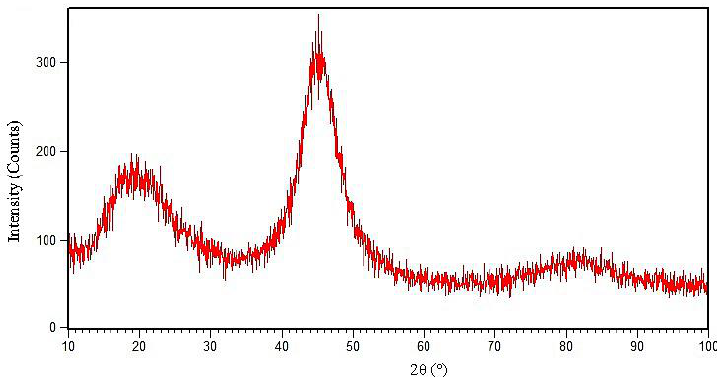
Figure 1. XRD pattern of BNi-9 amorphous interlayer foil with composition Ni 78.92 Si 7.54 B 13.07 Fe 0.45 .